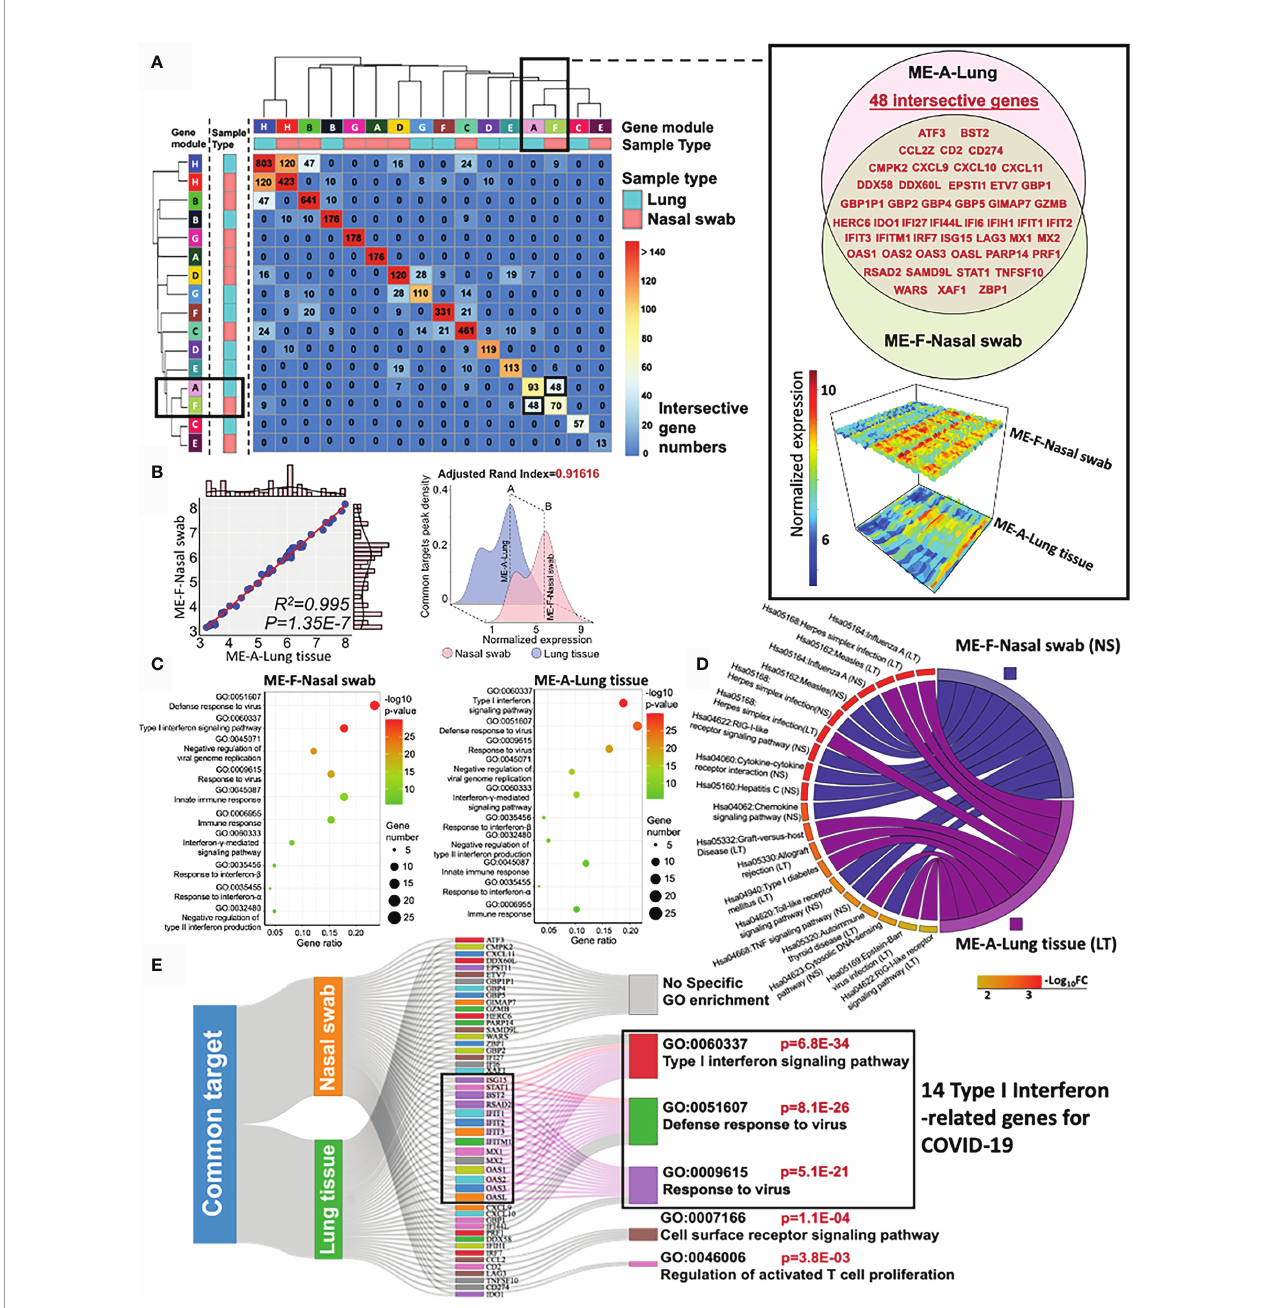
FIGURE 4 | High preservation of Type I interferon gene from nasal swab and postmortem lung tissue in COVID-19. (A) A two-dimensional matrix shows the overlap genes in modules from nasal swab or lung tissue. The black rectangles represent the interesting gene module showing a large proportion of overlapped genes in either ME-A-Lung or ME-F-Nasal swab. The detailed information of intersective genes with normalized expressions from ME-F-Nasal swab and ME-A-Lung are shown in the right panel. (B) Linear relationship and adjusted rand index between ME-F (Nasal swab) and ME-A (Lung). (C, D) GO and KEGG functional enrichment analysis for ME-F (nasal swab) and ME-A (lung tissue). (E) Functional genes for corresponding enrichment annotations shown in a Sankey